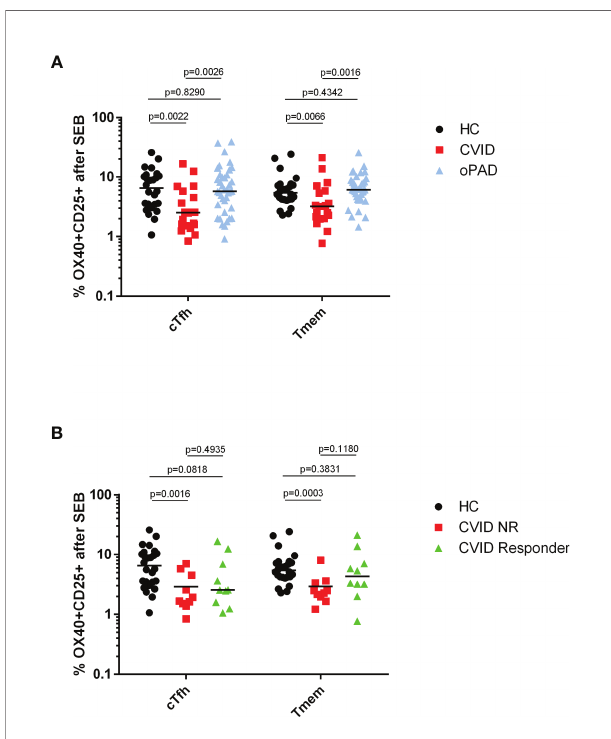
FIGURE 5 | Defective SEB-induced activation of circulating follicular T helper cells and CXCR5-negative CD4 memory T cells from CVID patients. Panel (A) human peripheral blood mononuclear cells (PBMC) from healthy controls (HC), CVID patients and patients with other, milder forms of primary antibody de fi ciency (oPAD) were stimulated for two days with the bacterial superantigen Staphylococcus enterotoxin B (SEB, fi nal concentration 1 µg/ml) before activation of circulating follicular T-helper cells (CD3 + CD4 + CD45RA − CXCR5 + , cTfh) and CXCR5-negative CD4 memory T cells (Tmem) was determined by measuring upregulation of CD25 and CD134 (OX40) with fl ow cytometry. Results are expressed as percent CD134 (OX40) and CD25 double positive cells relative to the respective CD4 + T cell subpopulation. Panel (B) human peripheral blood mononuclear cells (PBMC) from healthy controls (HC), CVID IgG antibody responders (anti-spike protein IgG antibody following second vaccination > three times cutoff = 33 RE(/ml) and CVID IgG antibody non- responders were stimulated for two days with the bacterial superantigen Staphylococcus enterotoxin B (SEB, fi nal concentration 1 µg/ml) before activation of circulating follicular T-helper cells (CD3 + CD4 + CD45RA − CXCR5 + ,